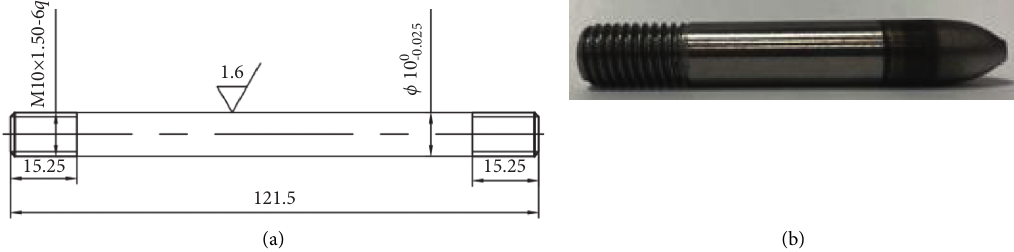
Figure 2: (a) Dimensions of tensile specimen of as-cast 42CrMo steel. (b) Specimen after tensile tests.